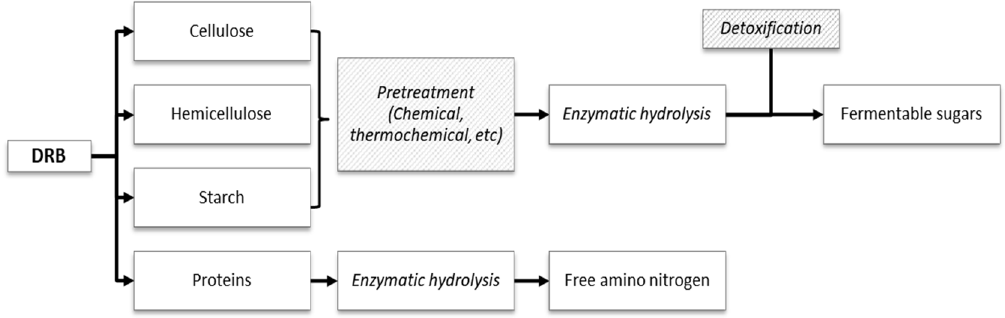
Figure 3. Diagram of the stages for the release of fermentable sugars and free amino nitrogen from defatted rice bran. Striped boxes indicate stages that are not always required.